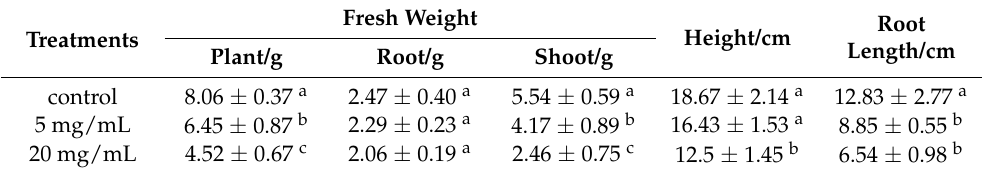
Table 1. The growth of tomato seedlings after exposure to a C. camphora extract for 14 days.